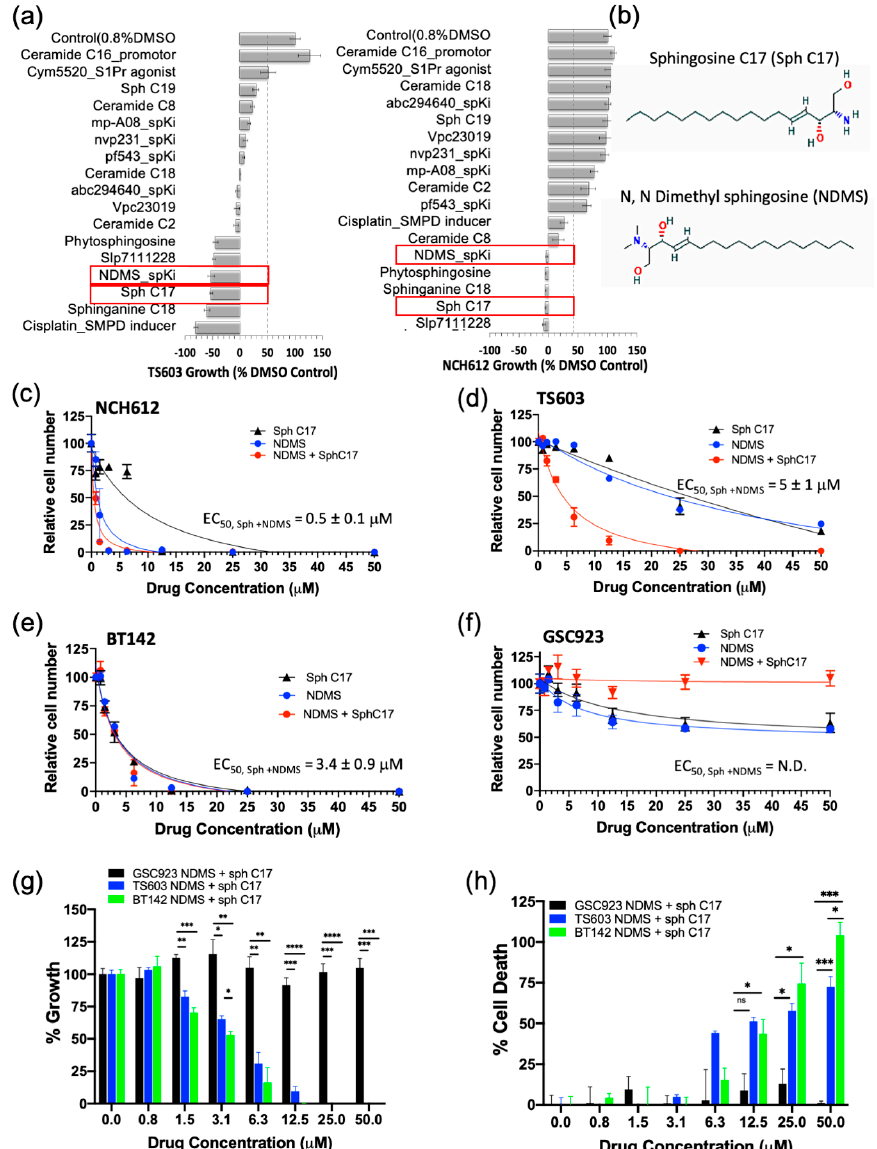
Figure 4. Modulating the sphingolipid pathway induces IDH mut -specific cell death. ( a ) Rational drug screen to include 17 bioeffector molecules and inhibitors of sphingolipid pathway for two oligodendroglioma cell lines (TS603 and NCH612). Red rectangles highlight the molecules chosen to be analyzed further. ( b ) Chemical structures of the most active sphingolipids resulted from the screen sphingosine C17 and N, N dimethyl sphingosine. ( c – f ) EC 50 measurements of three IDH mut glioma and one IDH WT glioblastoma cell line. The EC 50 measurements were obtained via fitting to the equation from Graph Prism software. N.D, not determined. ( g ) Side-by-side comparison of growth rates between IDH WT (GSC923, black) and IDH mut (BT142, green; TS603, blue) cell lines treated with the drug combination of Sph C17 and NDMS. The data were obtained using a CCK8 assay described in the Methods section and plotted with Graph Prism 8.2.1. ( h ) Side-by-side comparison of percent cell death between IDH WT (black) and IDH mut cell lines (BT142, green; TS603, blue) treated with the drug combination of Sph C17 and NDMS. The data were obtained using a CCK12 assay described in the Methods section and plotted with Graph Prism 8.2.1. Statistical analysis (t-test) was conducted assuming equal variance, p -values are represented as follows: **** p < 0.00005, *** p < 0.0005; ** p < 0.005; * p < 0.05; ns, not significant. For simplicity, only significant values are shown on the